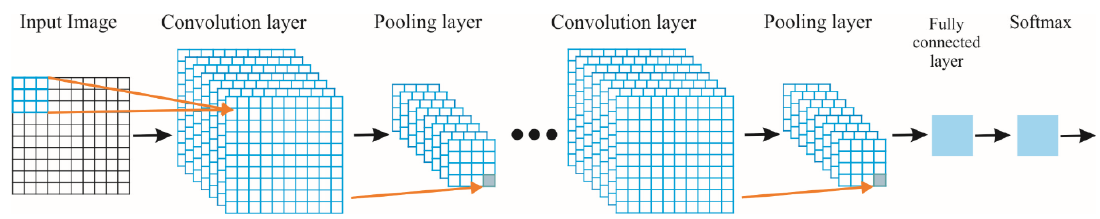
Figure 5. Convolutional Neural Network.